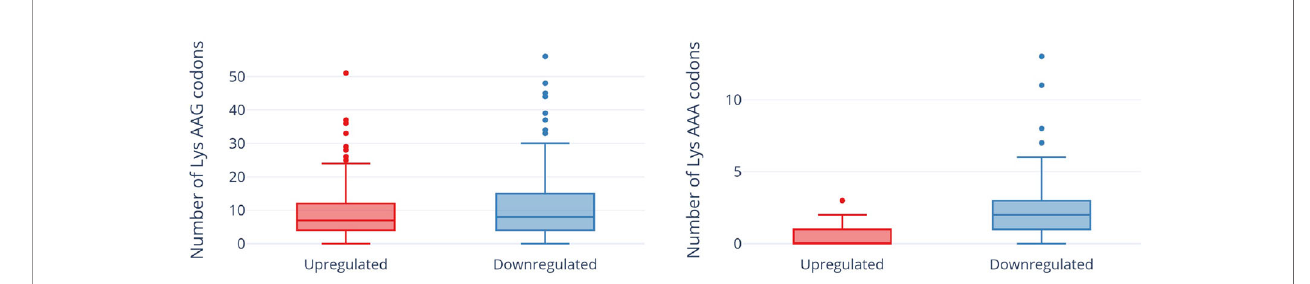
FIGURE 6 | Expression of MazF-ms leads to global proteomic shifts based on the Lys AAA, but not Lys AAG, codon content. Distribution of AAG (left) or AAA (right) codons in signi fi cantly upregulated or downregulated proteins. Outliers are shown as individual dots.